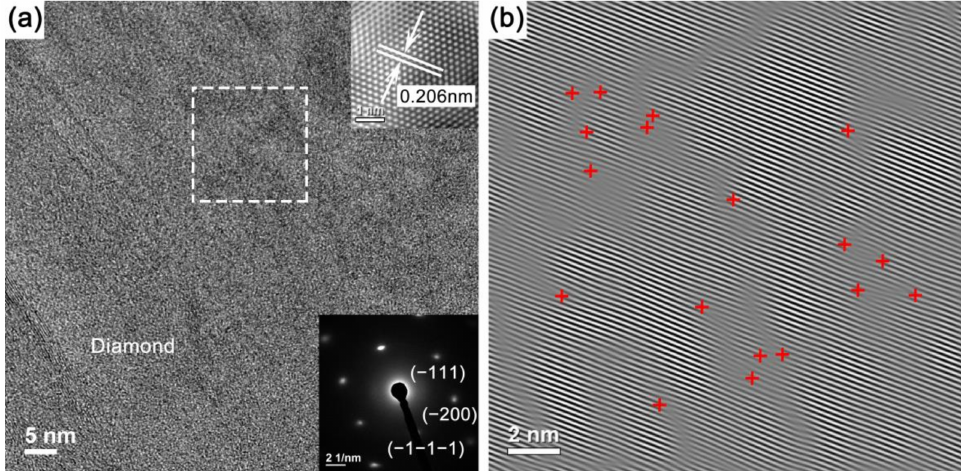
Figure 4. ( a ) High-magnification cross-section HRTEM image of SCD layer near the hillock interlayer with selected area filtered HRTEM micrograph (top right insert), and the bottom right insert shows a typical selected area electron diffraction pattern; ( b ) inverse fast Fourier transform image of selected area marked by white-dashed box in ( a ), and the red cross indicates the